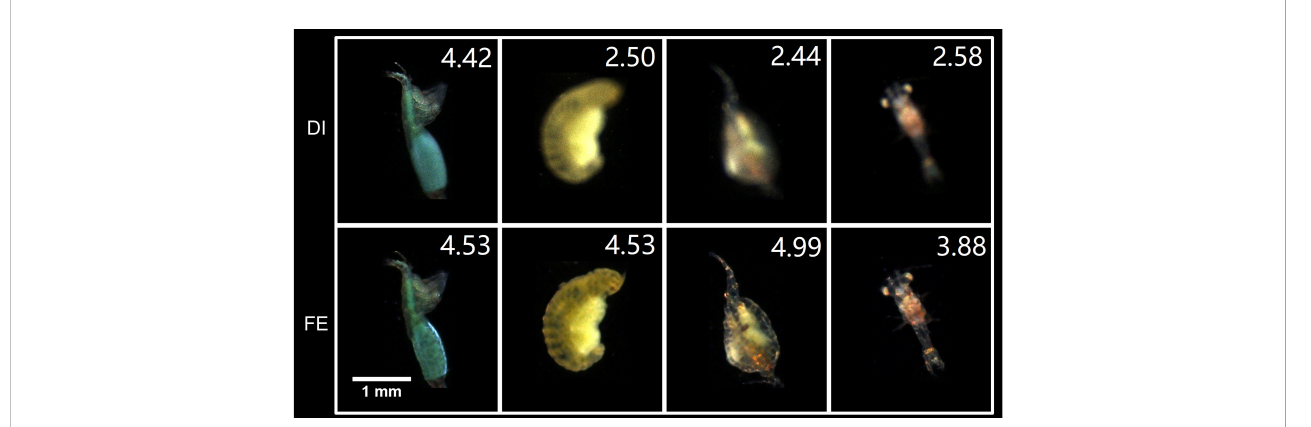
FIGURE 11 Focus-extension comparisons of IsPlanktonFE on some representative in situ marine plankton ROIs acquired by IPP. The value at the top-right corner of each ROI indicates its focus